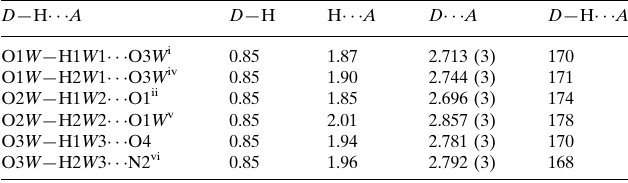
Hydrogen-bond geometry (A˚ , (cid:2)